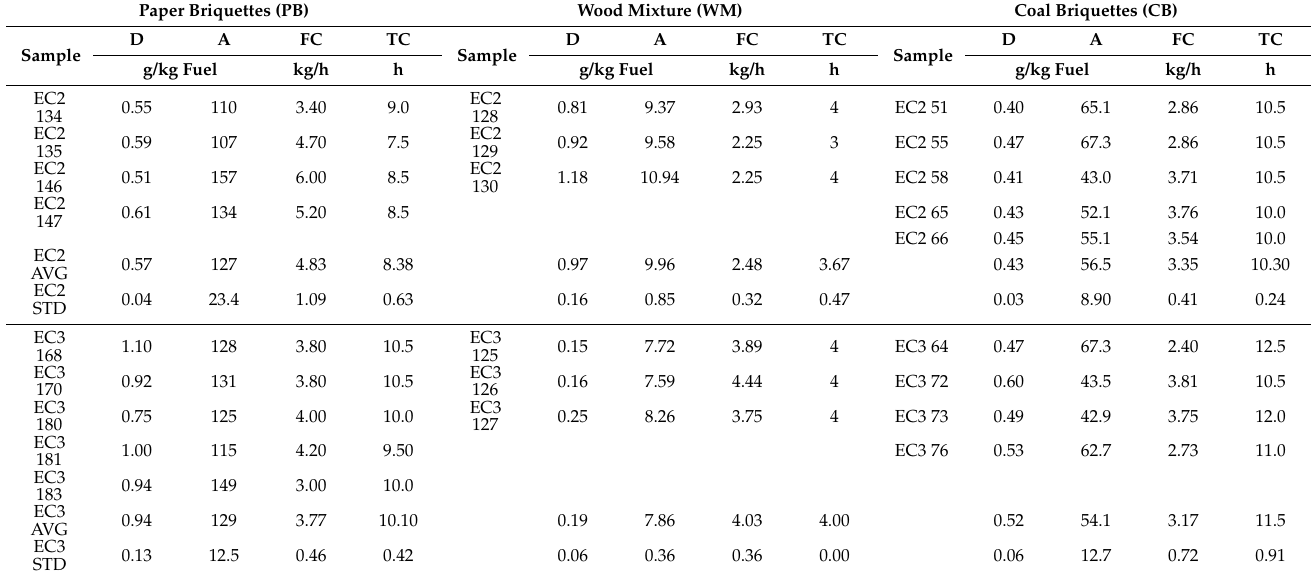
Table 2. Conditions for combustion experiments in EC2, EC3